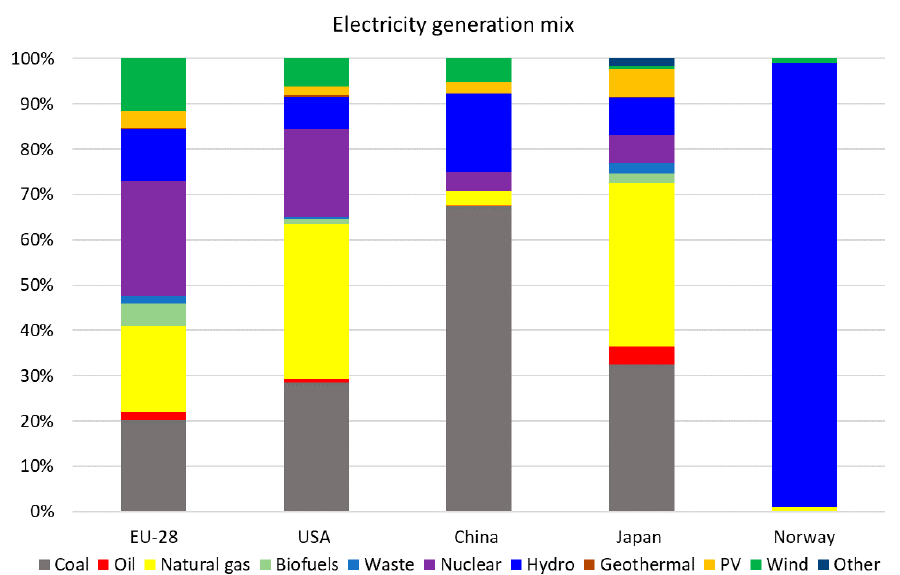
Figure 15. Electricity generation mix in selected countries 2018 (Data source: [90], own analysis).